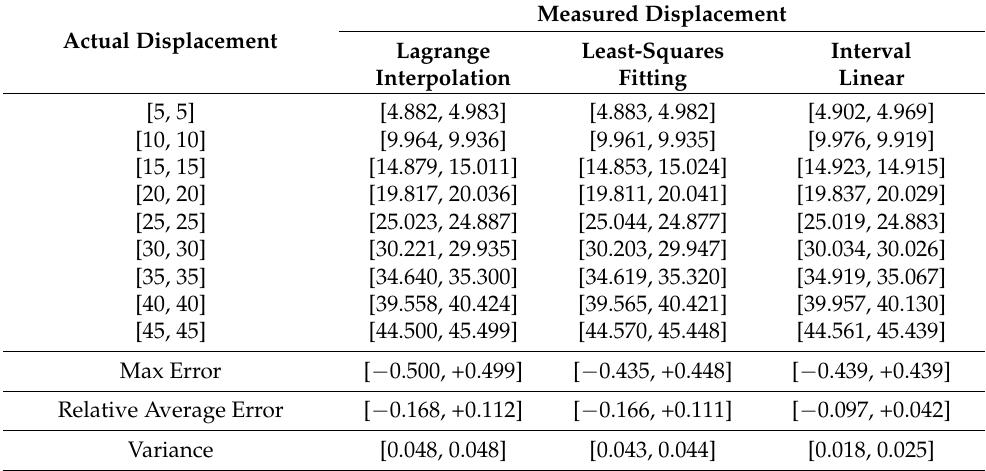
Table 2. Comparison of actual displacement [ r , z ] and measured displacement [ r , z ] under different methods when the inter-axis angle is 20 ◦ . ( r -horizontal displacement in mm, z -vertical displacement in mm).